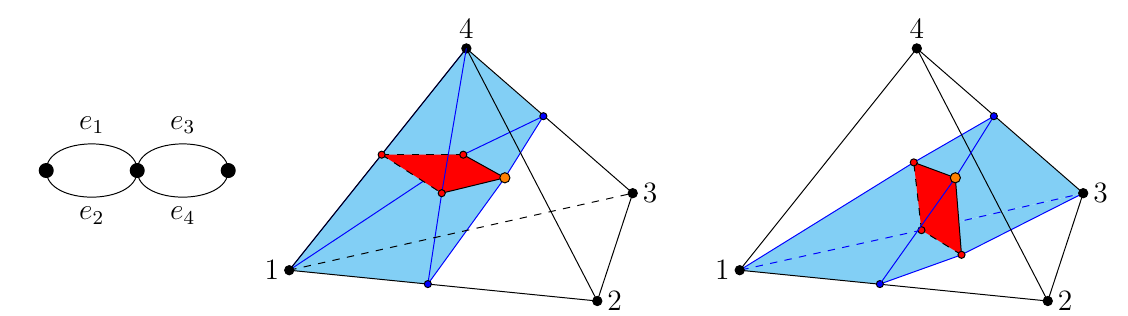
) that are represented by the G